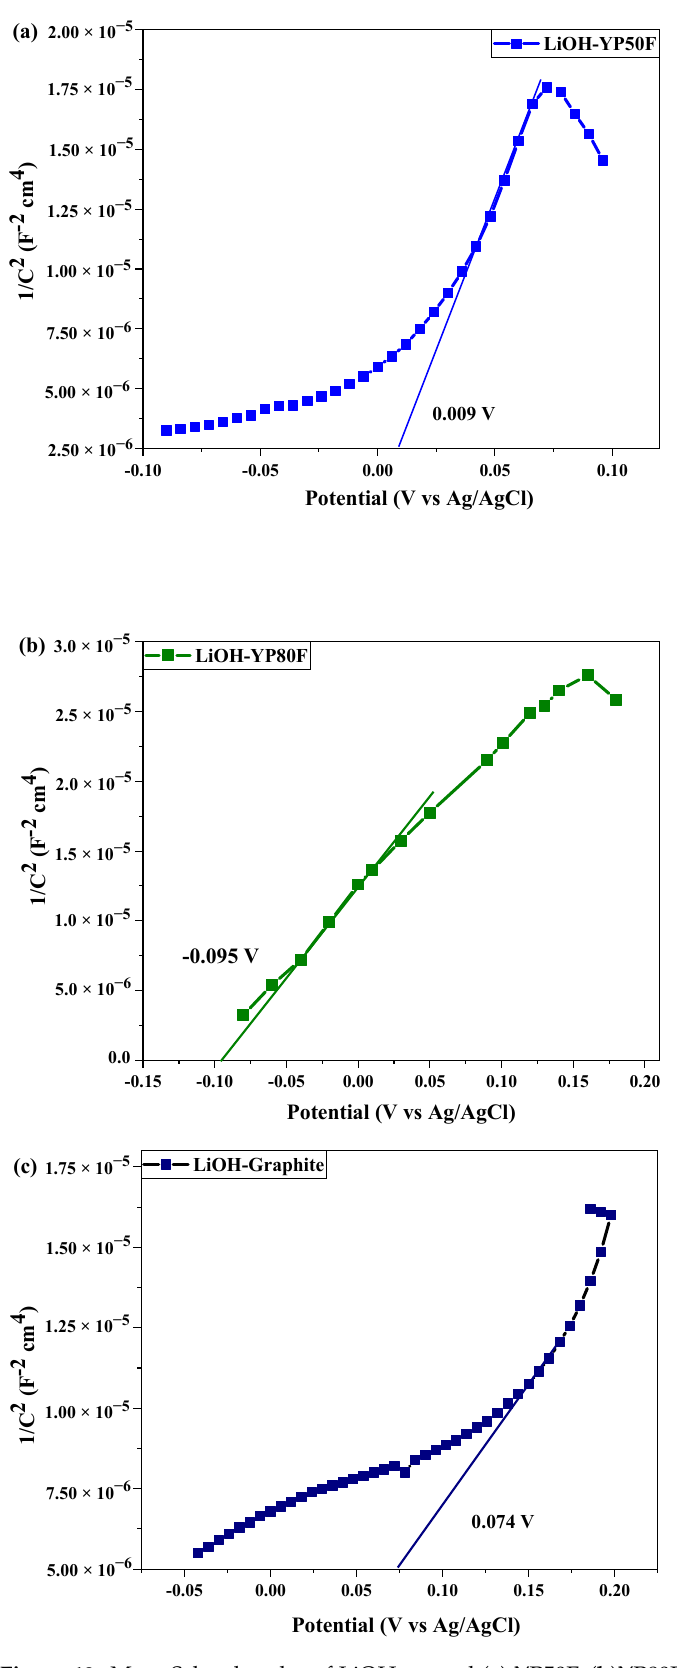
Figure 13. Mott–Schottky plot of LiOH-treated (a) YP50F, (b)YP80F, and (c) graphite (Cu-current collector and 5% KOH